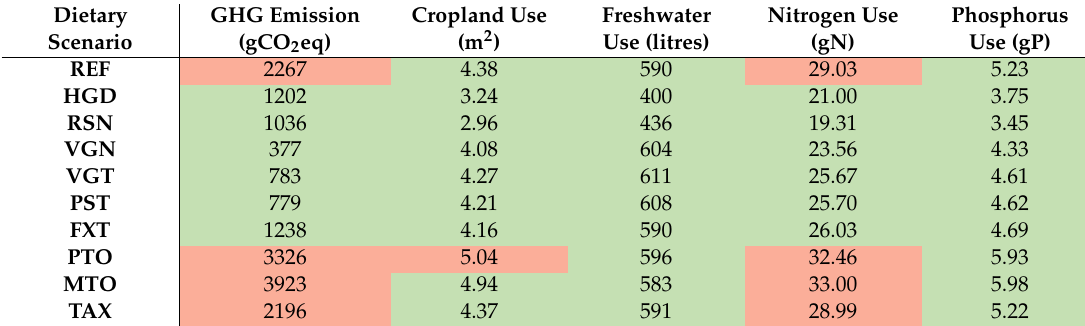
Table 4. The daily per capita food related environmental footprint of current Swiss diet (REF) and nine alternative diets.